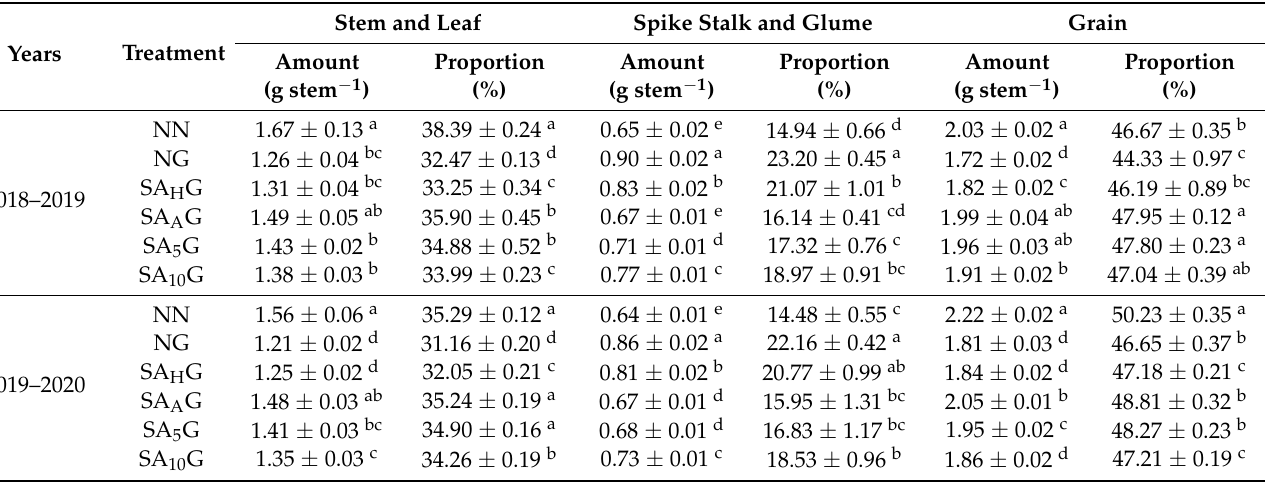
Table 3. Effects of exogenous salicylic acid (SA) spraying on the amount and proportion of dry matter in various organs of wheat at the mature stage under high temperature stress during the grain-filling stage in